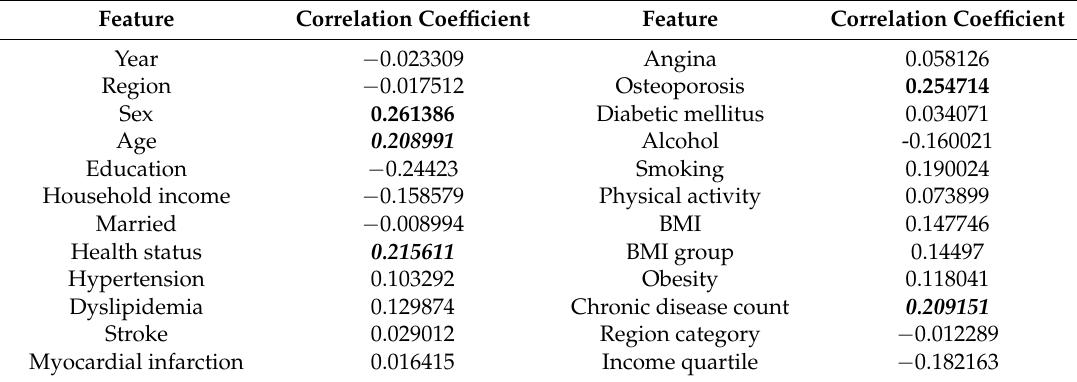
Table 2. Correlation coefficient of initial features. BMI: body mass